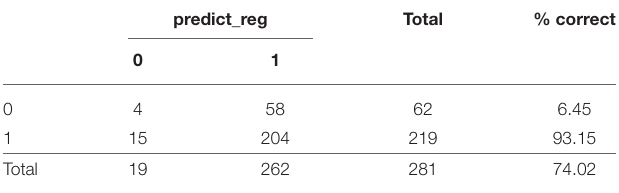
TABLE 12 | Logistic regression confusion matrix (classification %).